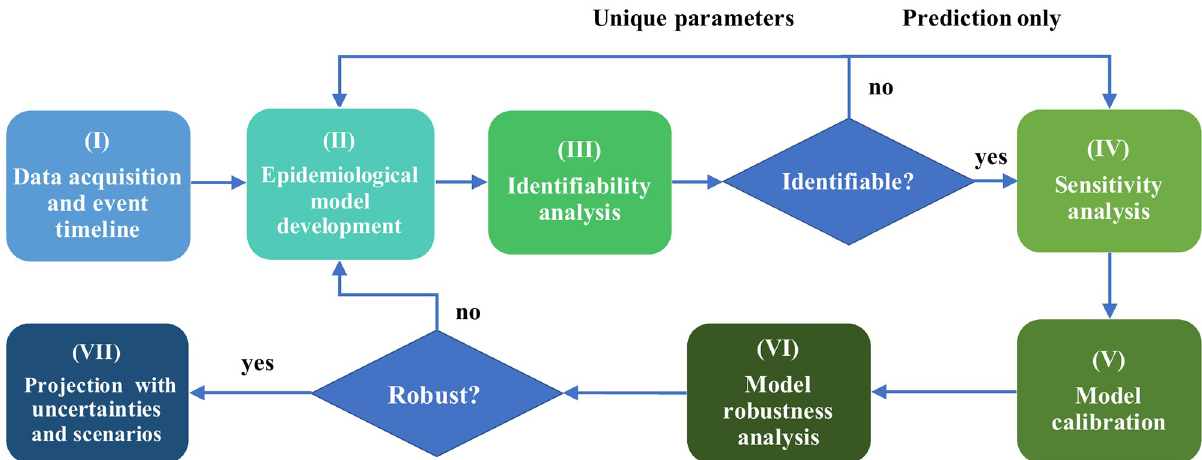
Fig 1. A general framework for building a trustworthy data-driven epidemiological model—An overview of the main contribution. In this work, we propose a general framework for building a trustworthy data-driven epidemiological model, which constructs a workflow to integrate data acquisition and event timeline, model development, identifiability analysis, sensitivity analysis, model calibration, model robustness analysis, and projection with uncertainties and scenarios. We first introduce a modified SEIR model that accommodates the pandemic data in New York City. Secondly, we study the structural identifiability, practical identifiability, and sensitivity to examine the relationship between the model’s data and parameters. We then calibrate the identifiable model parameters using simulated annealing and MCMC simulation. Model robustness is then checked to study how the model behaves under random perturbations. In addition, we demonstrate the model’s projective capabilities with uncertainties. Finally, reopening scenarios are investigated as a reference for